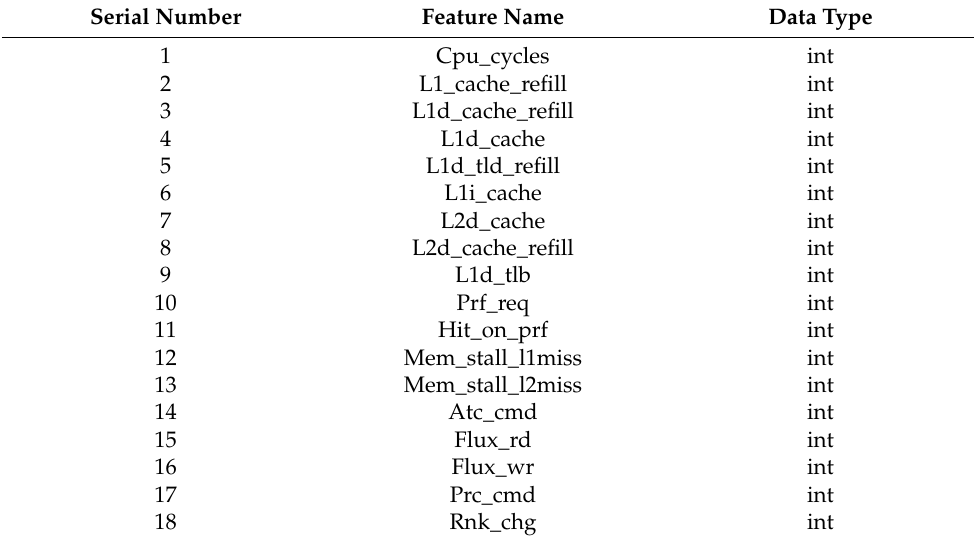
Table A1. Data features remaining after data